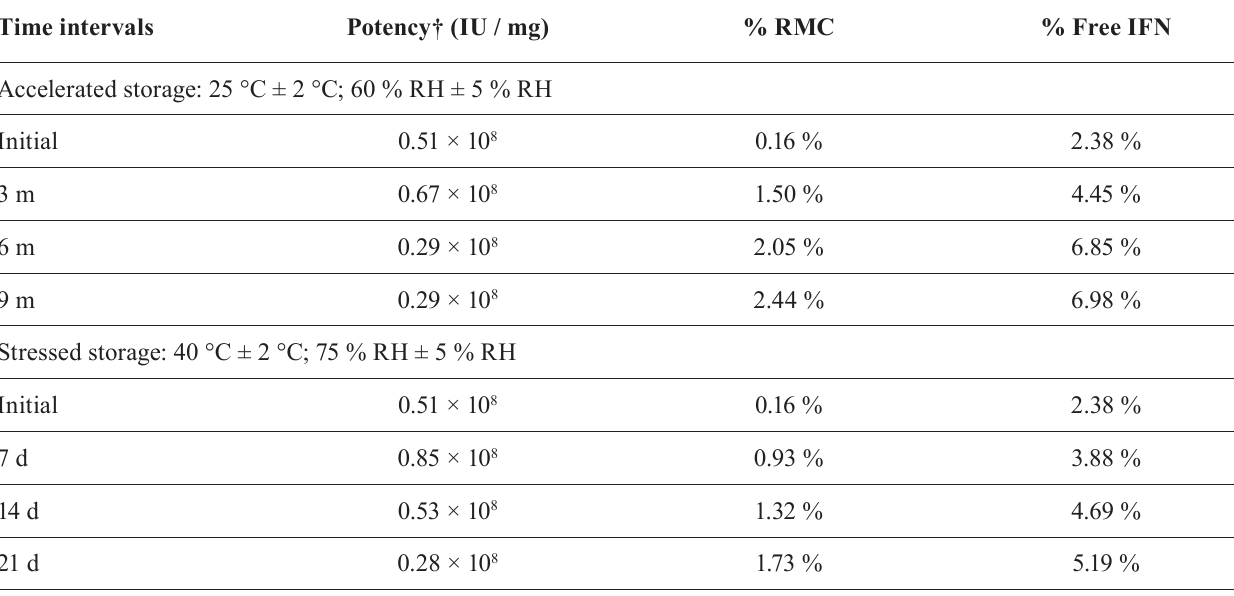
TABLE VI - Formulation D with 80 µg / 0.5 mL strength – exposed to different temperature conditions